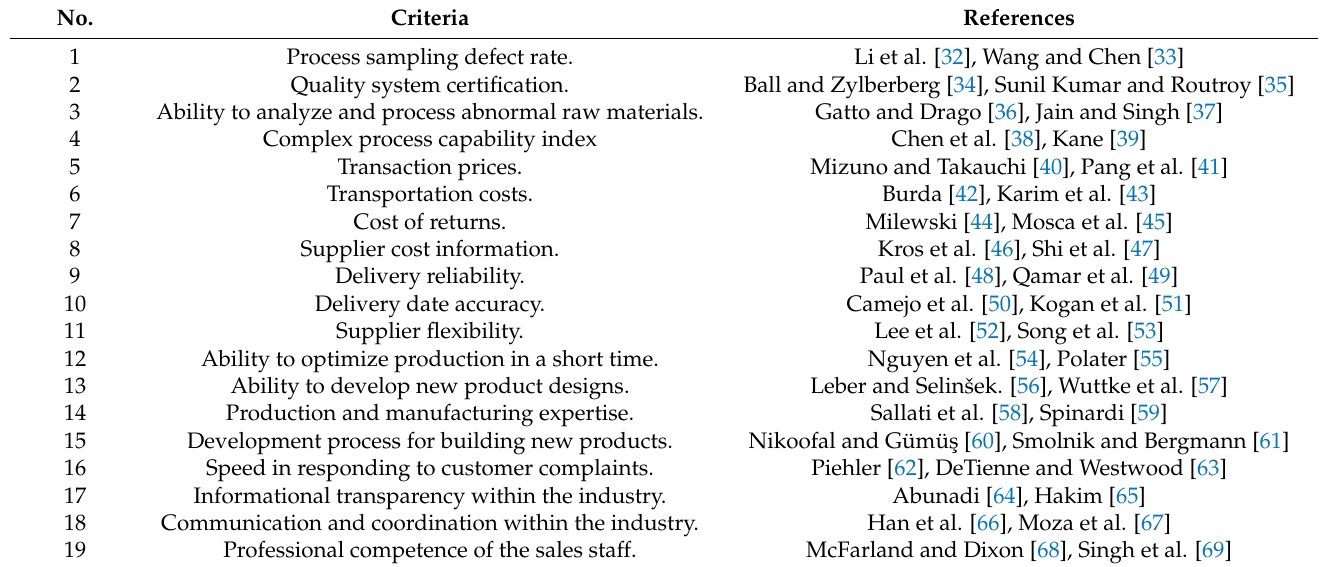
Table 2. Supplier selection criteria considered in this